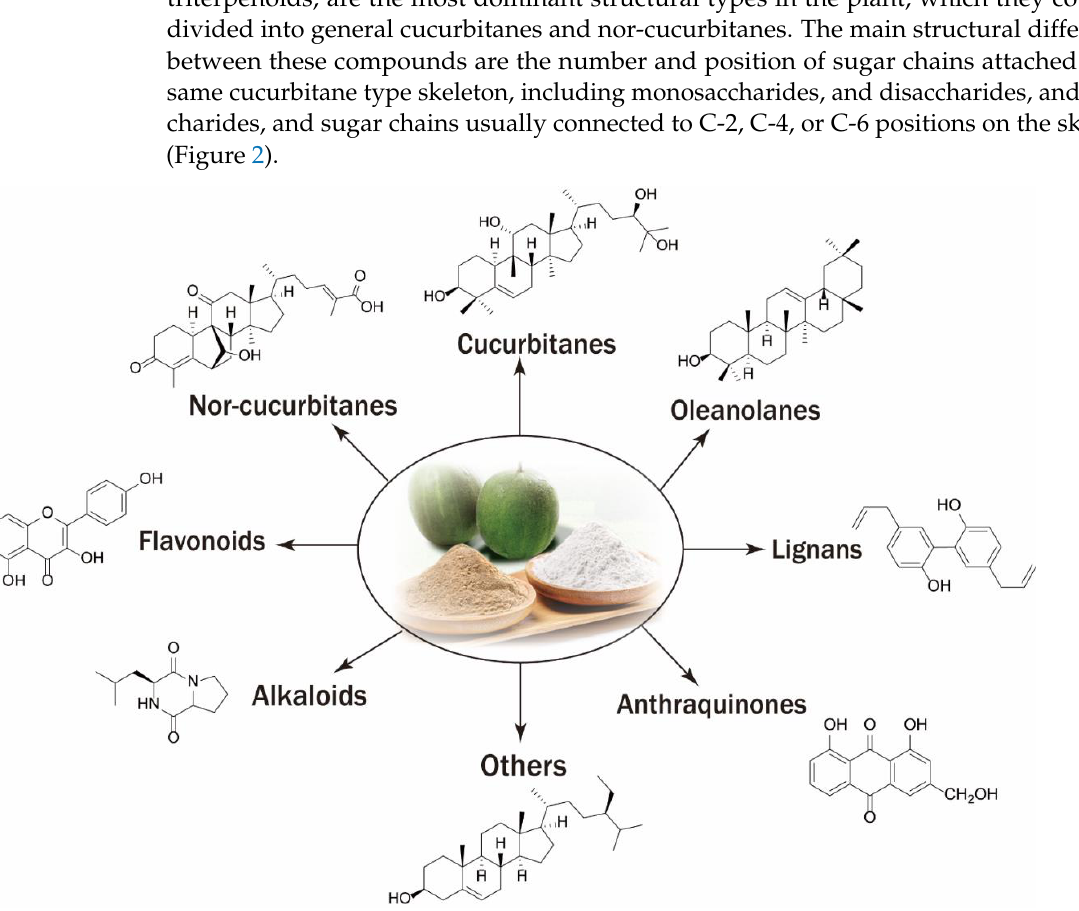
Figure 2. Main types of secondary metabolites in Siraitia grosvenorii .